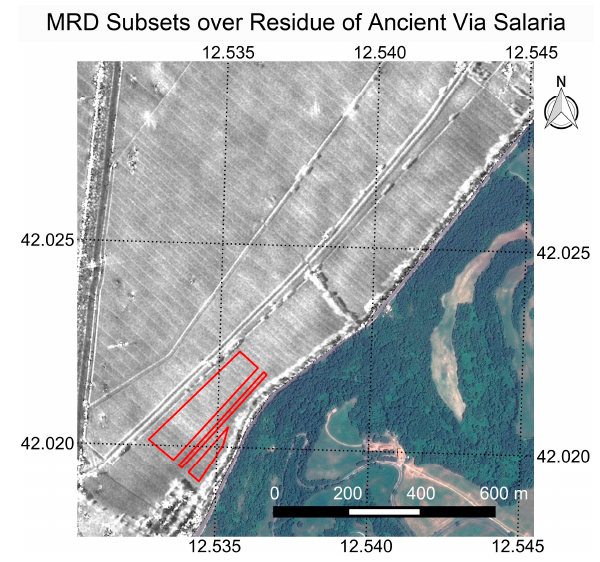
Figure 50. Subset areas used for MRD contrast analysis shown as red polygons over and outside of the Via Prenestina residue. Polygons are overlain on the image of filtered σ 0 backscatter acquired on 7 April 2013 and Pleiades image acquired on 22 May 2014. COSMO SkyMed data provided by the Italian Space Agency. Pleiades data provided by the European Space Agency.